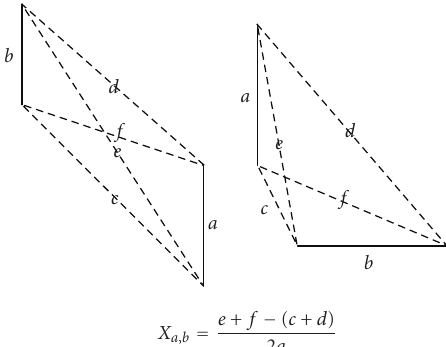
Figure 15: View factor of parallel and perpendicular plates.